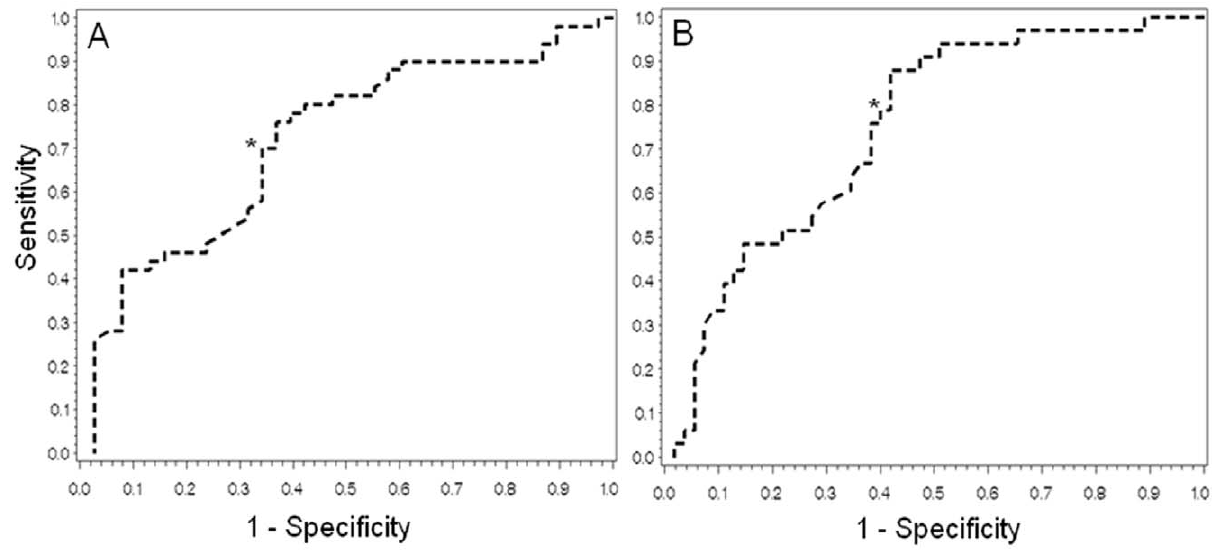
Figure 2. Receiver Operating Characteristic (ROC) Curves For The Identification Of Diabetic Sensorimotor Polyneuropathy (Panel A) And Subclinical Sural Nerve Impairment (Panel B) By LDI FLARE Area In The 89 Subjects With Type 1 Diabetes. The ROC curve in Panel A employed as the outcome the ‘‘England criteria’’ for DSP. Area under the curve was 0.72 and the threshold on the curve with optimal operating characteristics ( # 1.90 cm 2 for ruling in cases, indicated by the asterisk) had a sensitivity of 66% and a specificity of 70%. The ROC curve in Panel B employed as the outcome the ‘‘sural nerve criteria’’ to define an earlier stage of nerve impairment that did the ‘‘England Criteria’’ definition for DSP. The area under the curve was 0.75and the single point on the curve with optimal operating characteristics (also # 1.90 cm 2 for ruling in cases, indicated by the asterisk) had a sensitivity of 79% and a specificity of 60%.